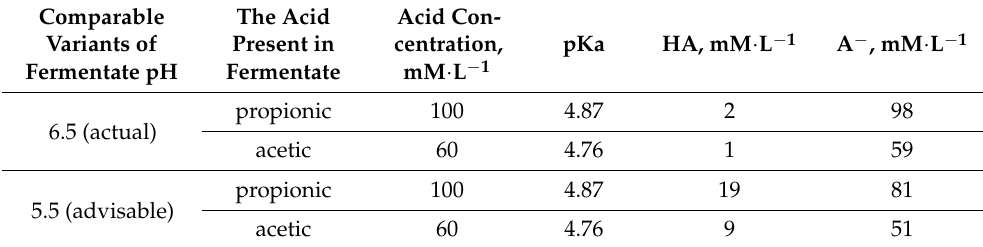
Table 6. The concentration of undissociated acids in the fermentates depending on pH. Comparable